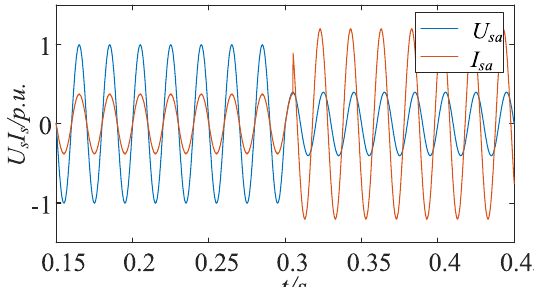
Fig. 10 Phase A voltage and current when the voltage drops in the rectified